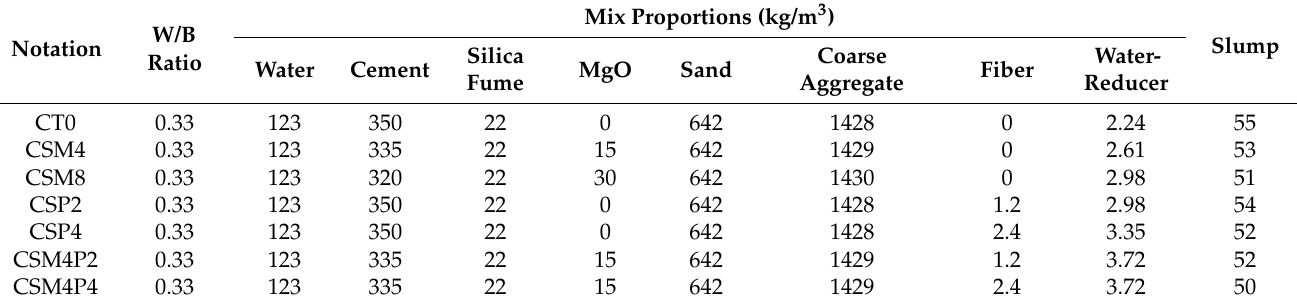
Table 3. Mix proportion and notation of hydraulic concrete added with MgO and/or PVA